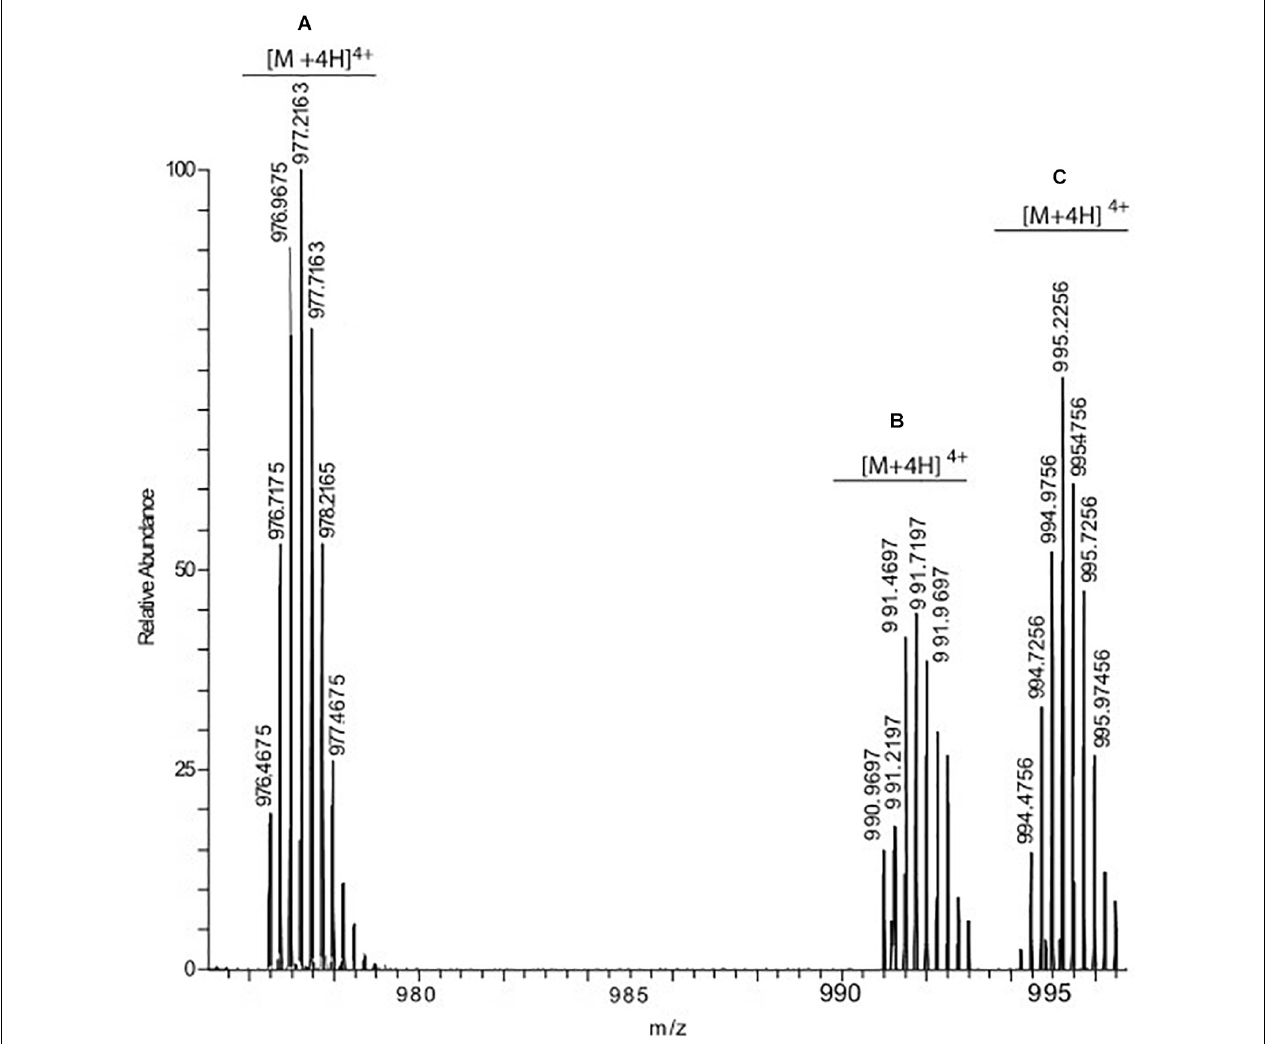
FIGURE 3 | hrESI MS spectrum of IAPP species resulting from the incubation of the peptide with MGO. Three compounds were detected: unmodified IAPP (species A) whose [M + 4H] 4 + ion was detected at m/z 976.4675, IAPP carrying one CML group (species B, [M + 4H] 4 + at 990.9697) and IAPP carrying one CEL group (specie C, [M + 4H] 4 + at